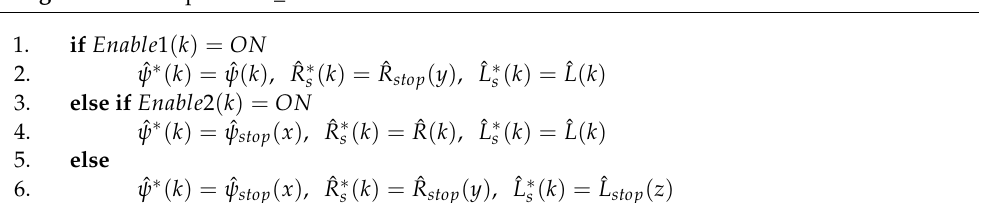
Algorithm A3. Update est _ star